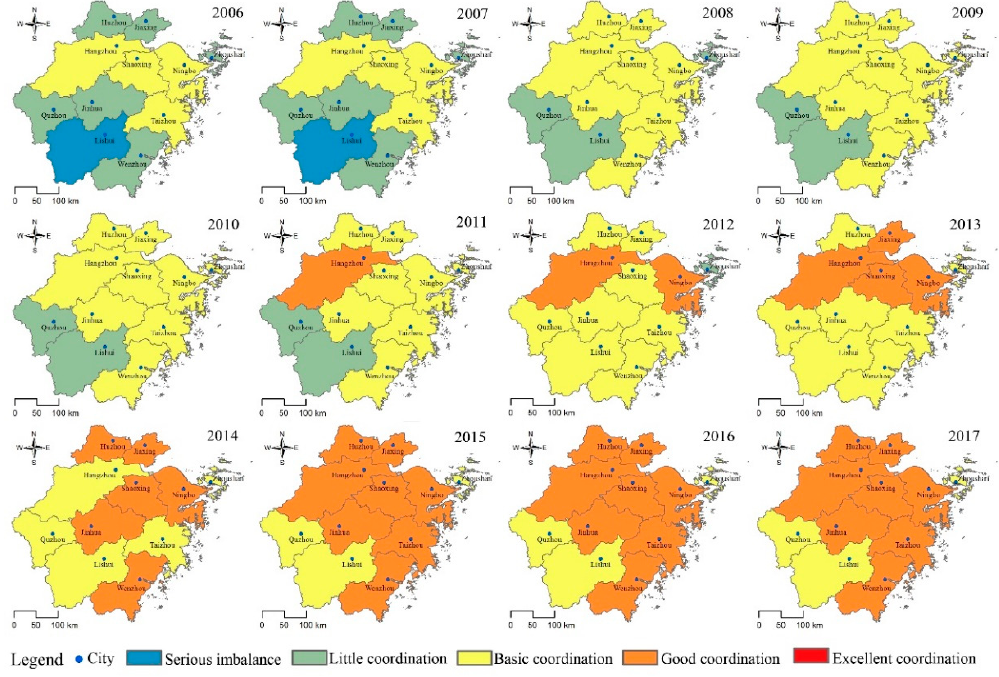
Figure 7. The coordination types of UTA in Zhejiang in 2006–2017.